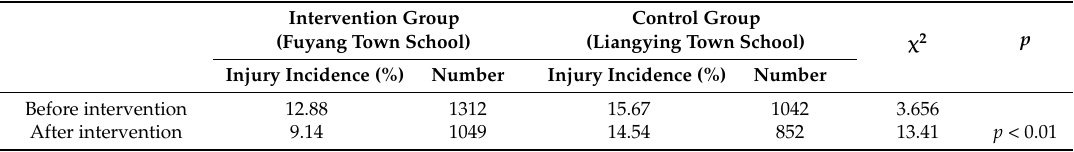
Table 1. A comparison of the bicycle injury rate in the intervention group and control